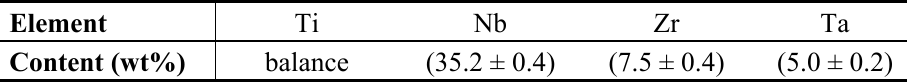
Table 1. Chemical analysis of the Ti-35Nb-7Zr-5Ta (TNZT) alloys.